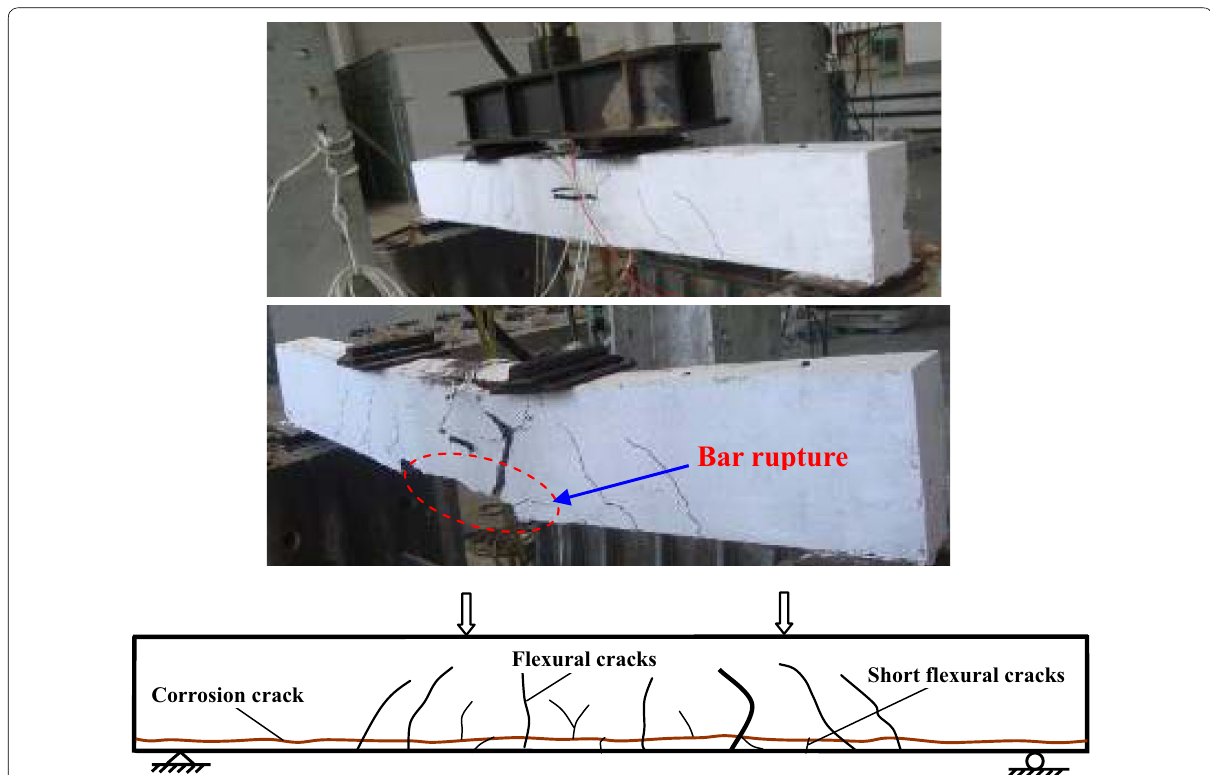
Fig. 2 Typical failure mode of corroded beams under fatigue